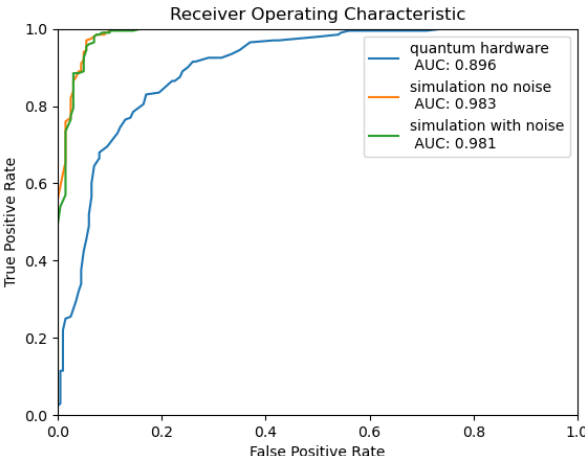
Figure 14. ROC curves and AUC for anomaly detection: simulated circuits with no noise (orange), simulated circuits with noise (green) and noisy quantum circuits